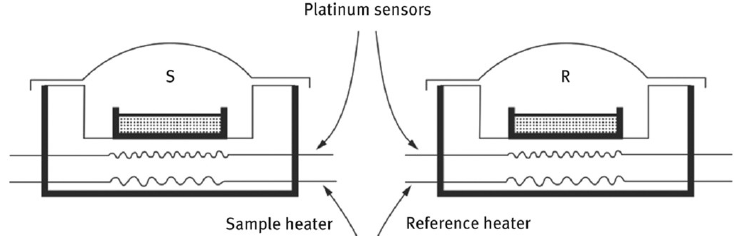
Figure 2. Schematic of a Power ‐ Compensated DSC Measuring Cell. Both Heaters and Sensors are Platinum Wires Configured in a Null ‐ Balance Mode of Operation.